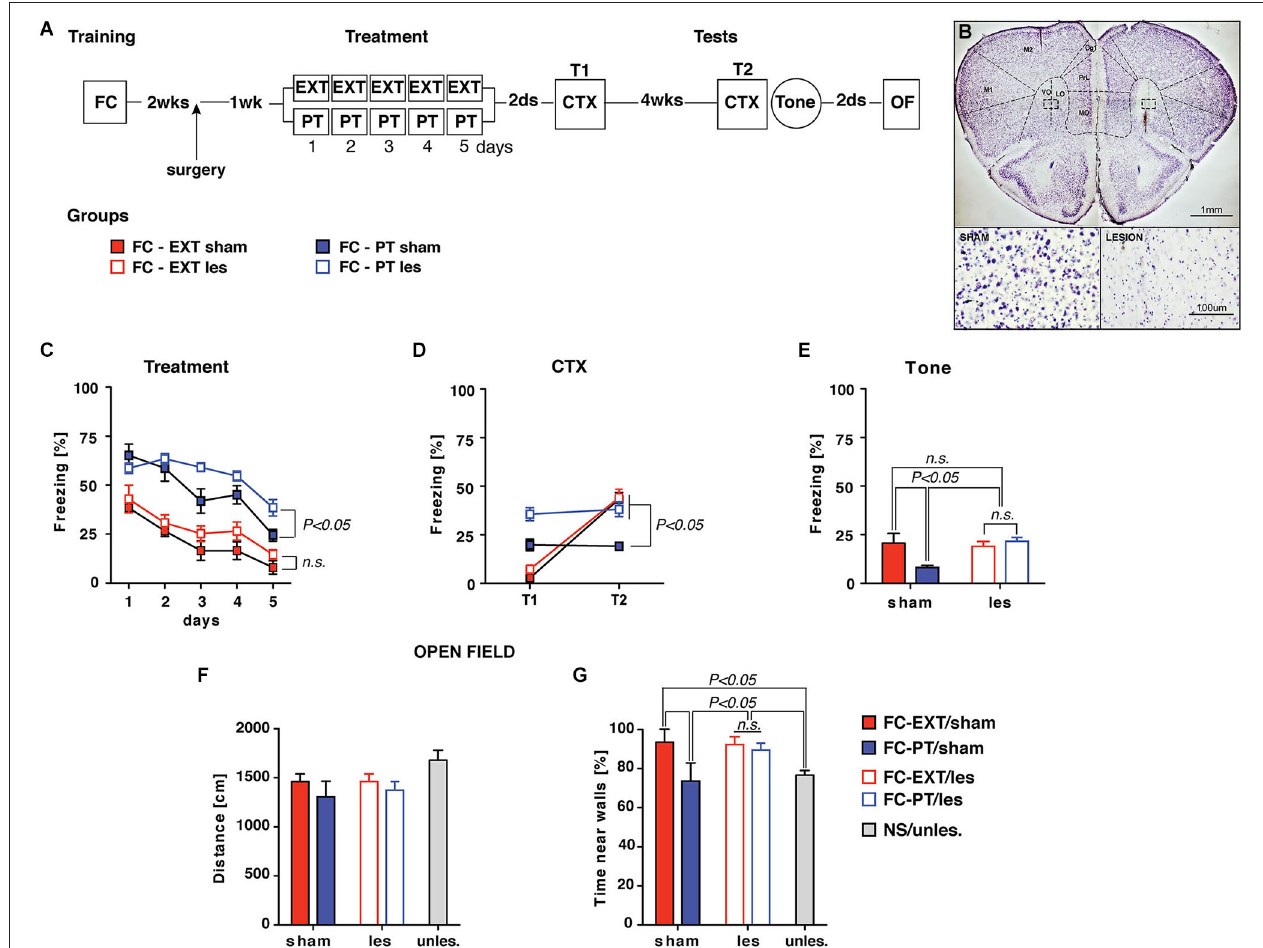
induced by PT treatment. ( D ) Freezing (%) in contextual memory test (CTX) carried out 2 days (T1) and 4 weeks (T2) after treatment. lOFC lesions block the spontaneous recovery prevention exerted by the PT treatment. ( E ) Freezing (%) in response to a neutral tone (Tone) in a new context. lOFC lesions block the reduction of fear induced by the PT treatment. ( F ) Distance (cm) travelled by animals in an open field. No significant differences among groups were observed, indicating that lOFC lesions did not affect locomotor activity. ( G ) Time (%) spent by animals near walls in the open field. FC-PT mice with lesions of lOFC spent more time near walls when compared with FC-PT/sham and NS/unles. mice, indicating that lOFC lesions reverted the comparisons (Duncan’s tests and Fisher’s tests) are depicted in the figure [n.s., not significant = P >